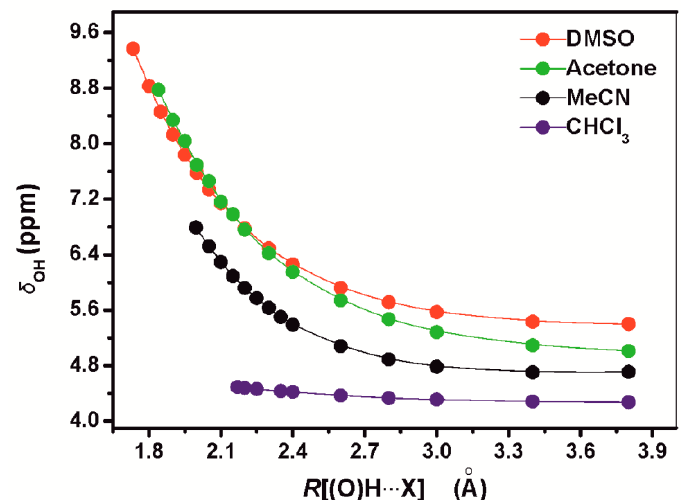
bond distances of − 8.9 ppm Å − 1 (R 2 = 0.977) (Figure 15b). The linear correlation between crystallographic data and δ (OH) 1 H chemical shifts suggested by Bertolasi et al. [27], therefore, may have a solid theoretical basis. Figure 14. The dependence of the OH proton chemical shifts, δ OH (ppm), of the 1:1 phenol + solvent complexes vs. the distance R[(O)H acetone (green), X = N for MeCN (black), and X = C for CHCl permission from [41]. Copyright 2013, The Royal Society of Chemistry.